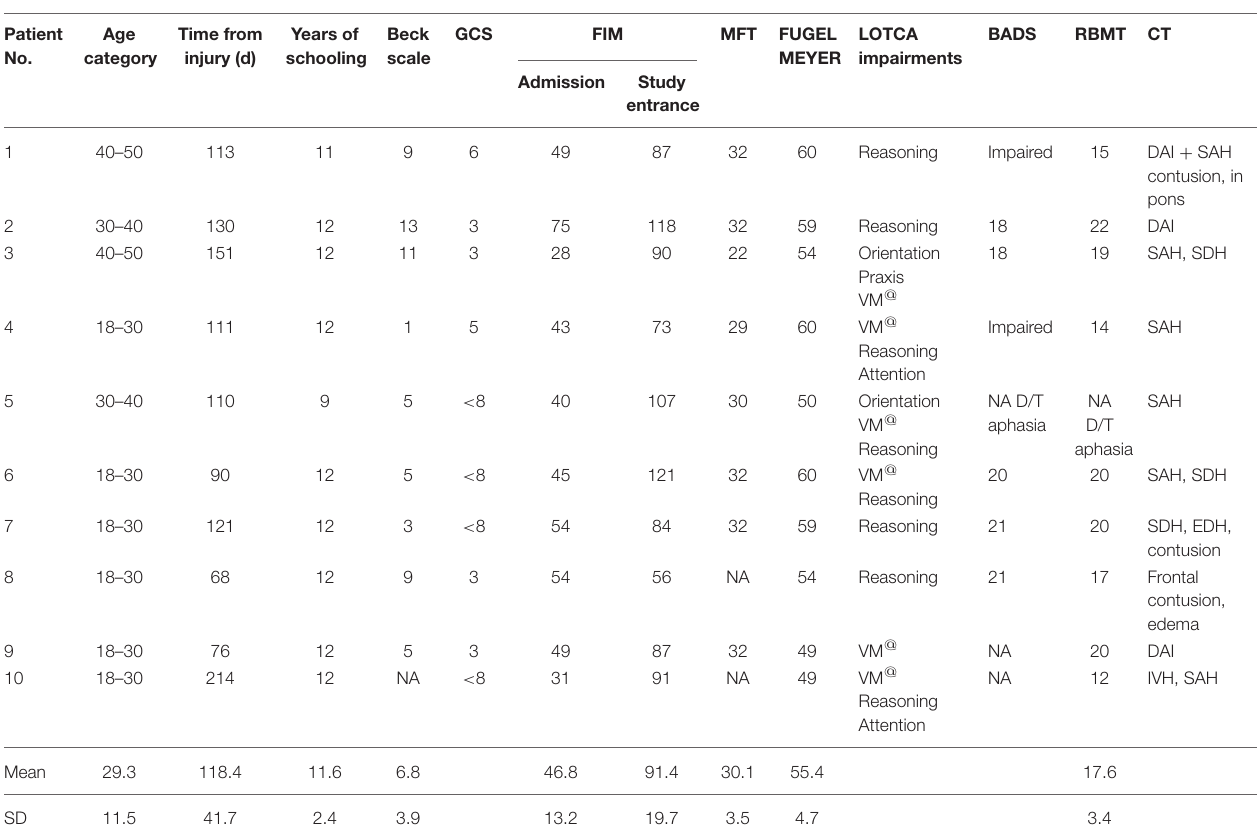
TABLE 1B | Control TBI group. Patients’ characteristics. Patient